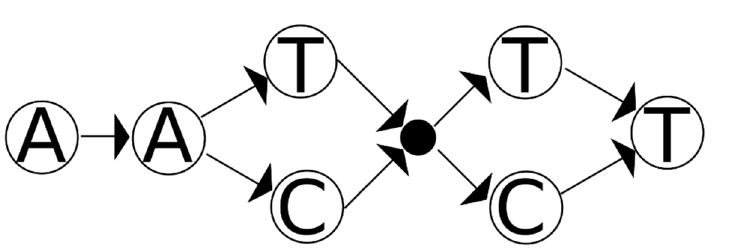
Figure 4. A remade version of the graph in Figure 2, using an epsilon node. In this version of the graph, all edges are known to be in the mixture. Note that this graph can be turned into the one from Figure 2 by examining all nodes reachable from a given node without consuming sequence and adding (uncertain) edges.